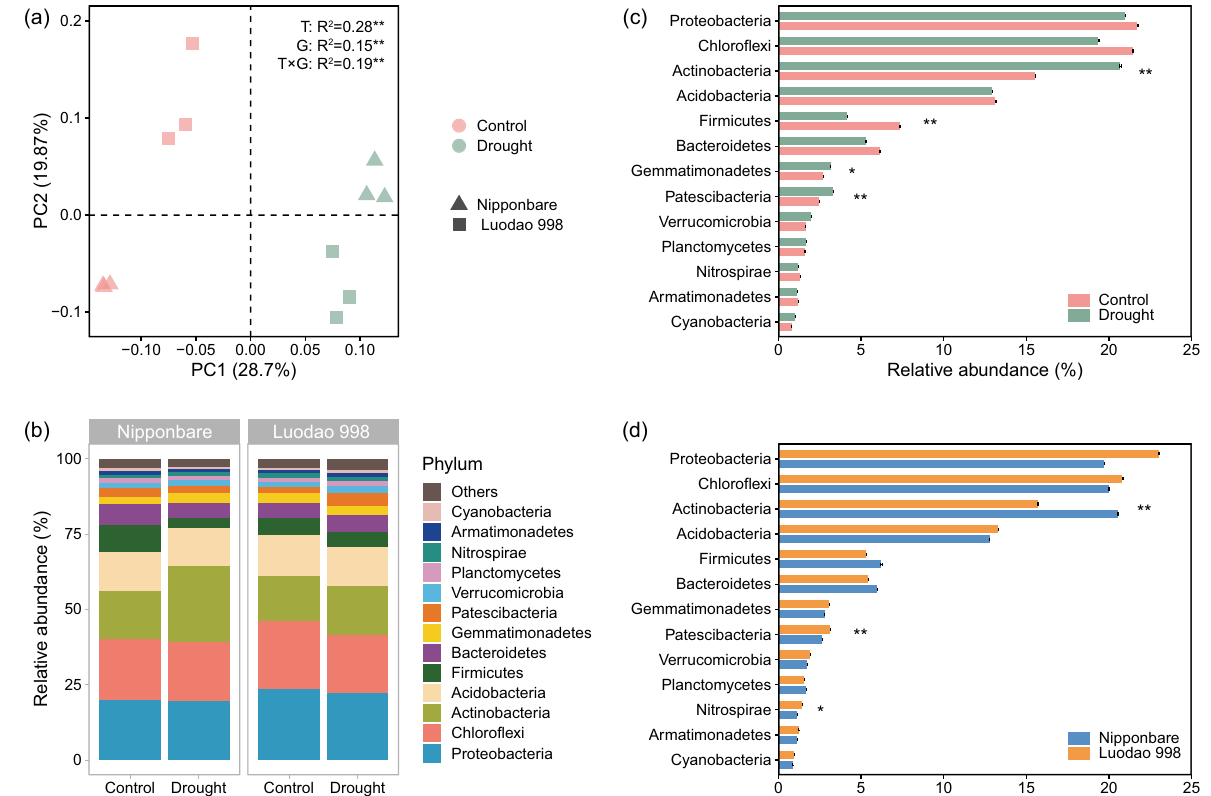
Fig. 2 Structure and taxonomic information of rhizosphere bacterial communities as affected by drought and genotype. a Principal coordinates analysis (PCoA) of rhizosphere bacterial communities based on Bray–Curtis distance at the OTU level. Asterisks indicate significant differences as defined by PERMANOVA (** p < 0.01). T Treatment, G Genotype. b Relative abundance of the dominated bacterial phyla in rhizosphere soil samples. Bar graphs showing the distribution of dominated phyla of rhizosphere bacterial communities c between the different watering treatments and d between the two rice genotypes. Asterisks indicate significant differences as defined by two-way ANOVA with LSD test (* p < 0.05 and ** p <